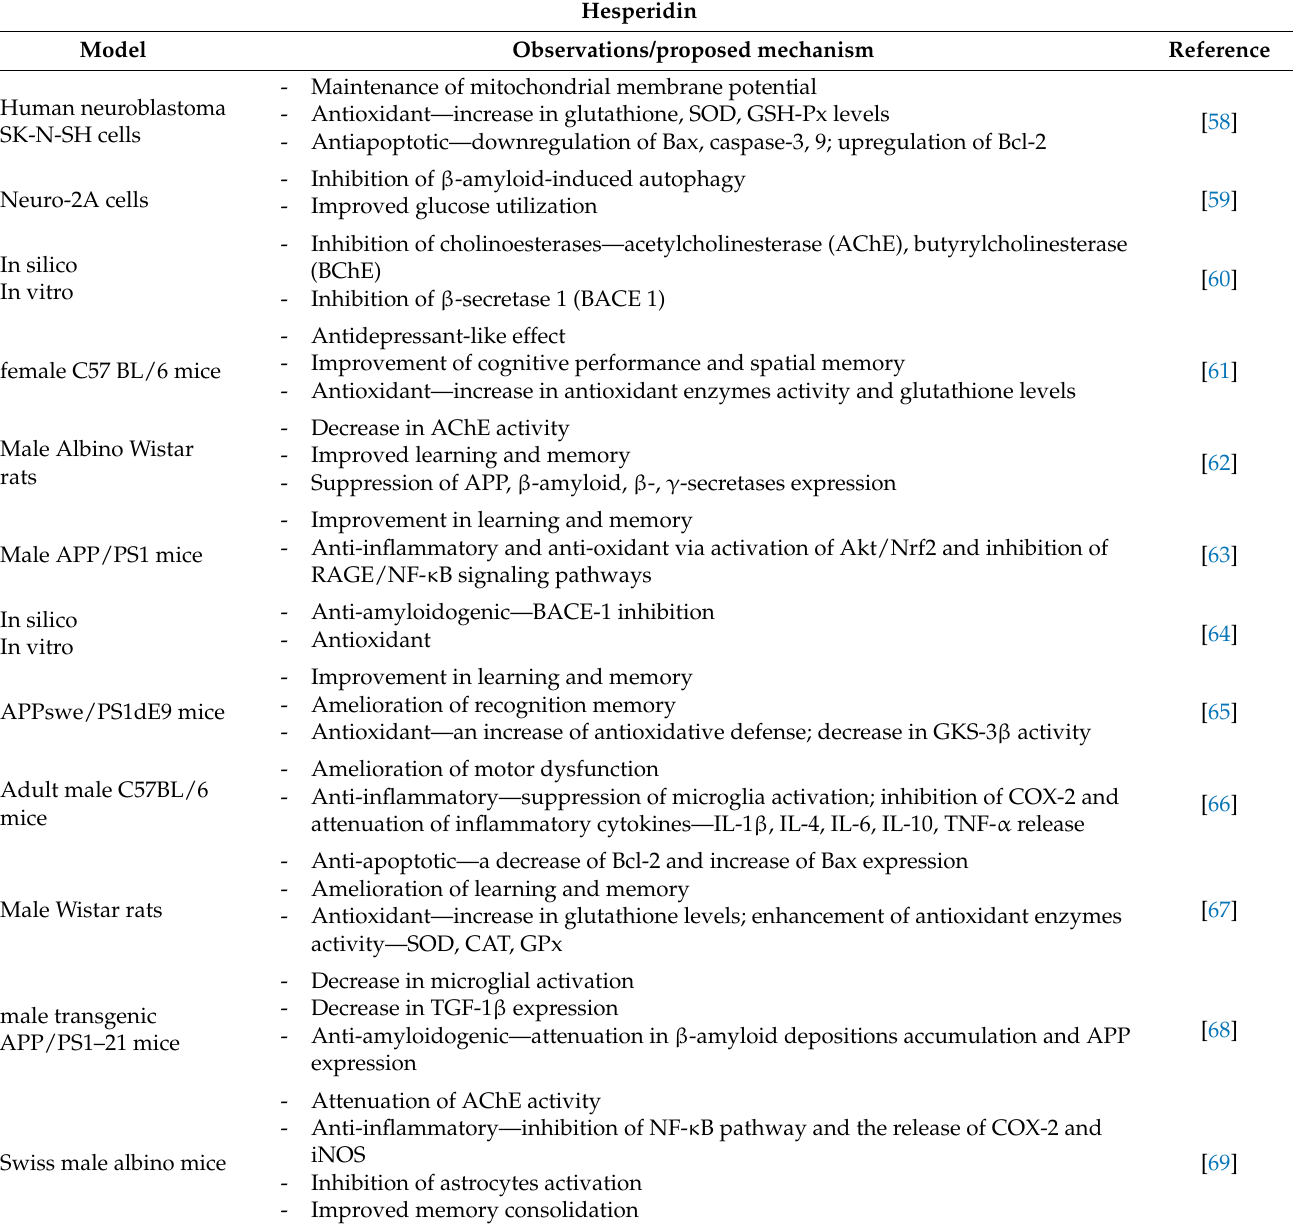
Table 2. Collected studies of pure compounds suggesting neuroprotective activity of hesperidin and